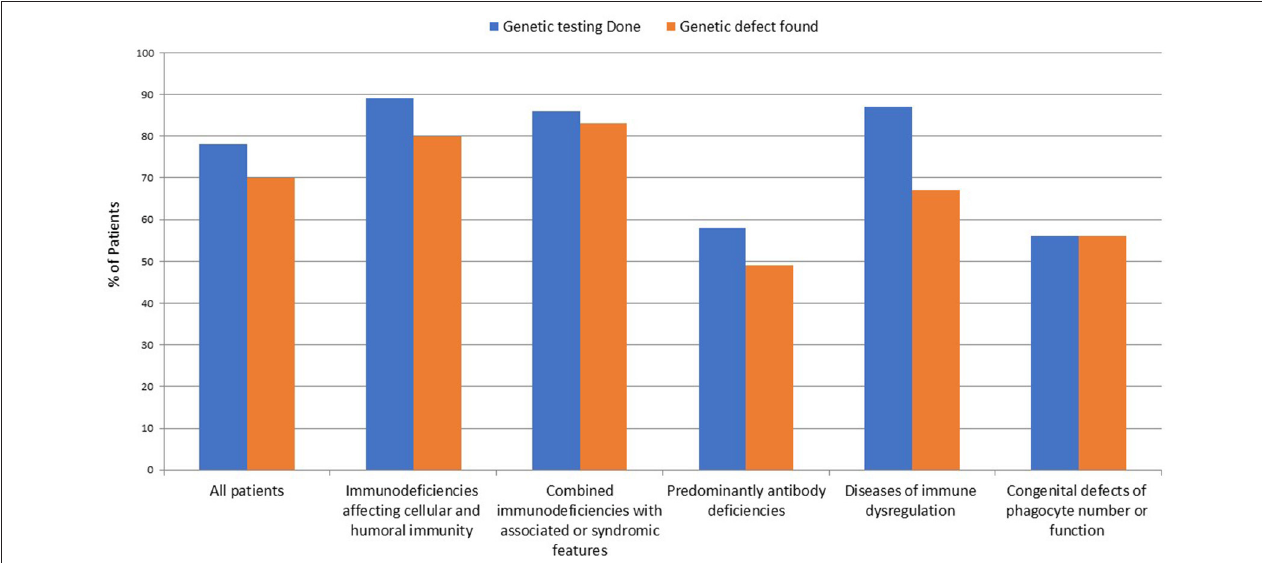
FIGURE 2 | Frequency of genetic testing among 264 patients registered in